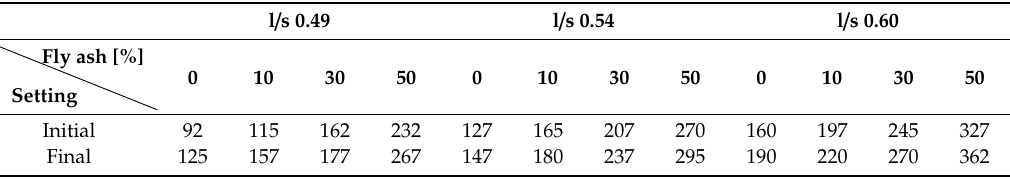
Table 3. Initial and final setting of geopolymers.